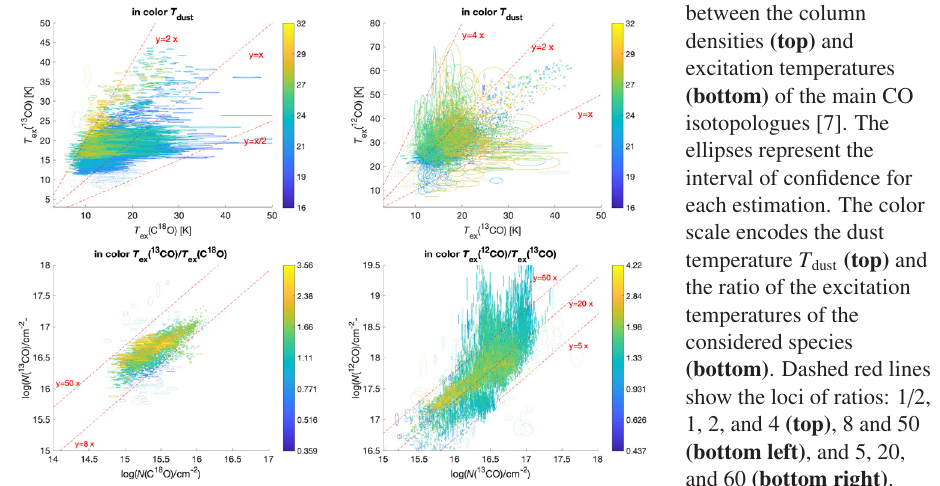
Figure 4. Comparison